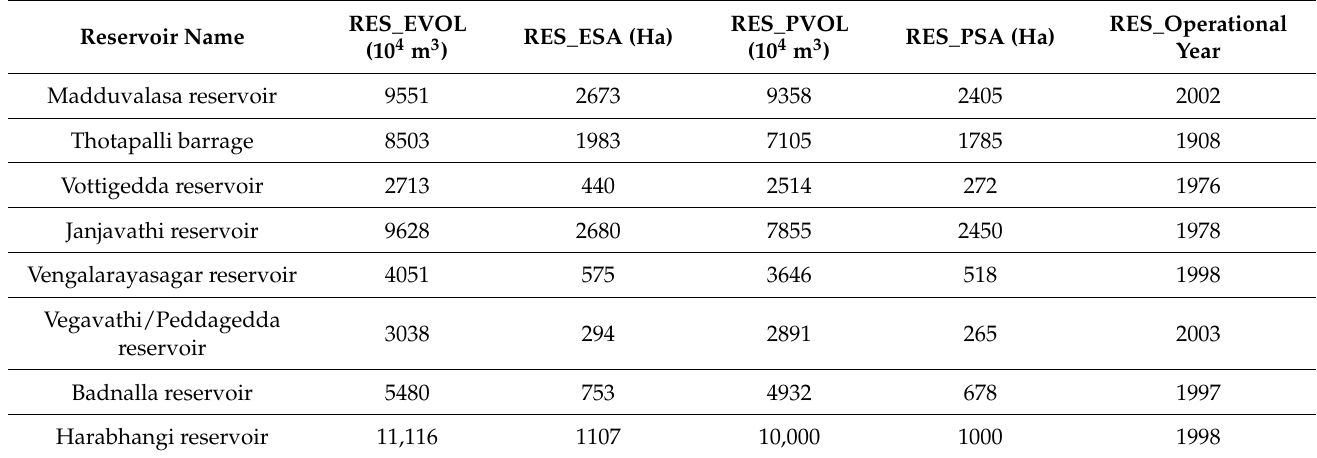
Table 1. Details of existing reservoirs in the Nagavali and Vamsadhara river